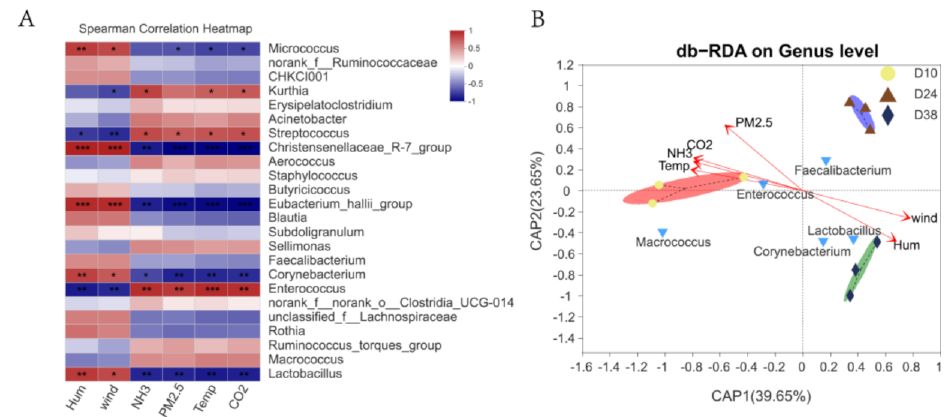
Figure 4. Correlation analysis of environmental control variables and the bacterial community of PM2.5: ( A ) Spearman correlation heatmap of bacteria and environmental control variables at the genus level; ( B ) db-RDA between environmental control variables and bacterial communities. * represents p < 0.05; ** represents p < 0.01; *** represents p < 0.001. Table 1. Linear ranking regression of environmental control variables and α -diversity.